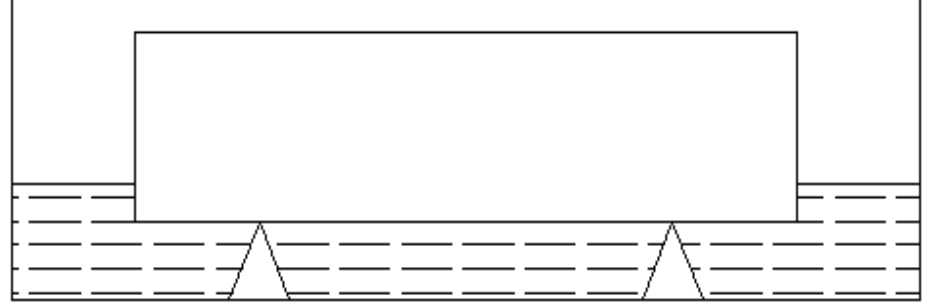
Figure 3. Capillary water-absorption test device.